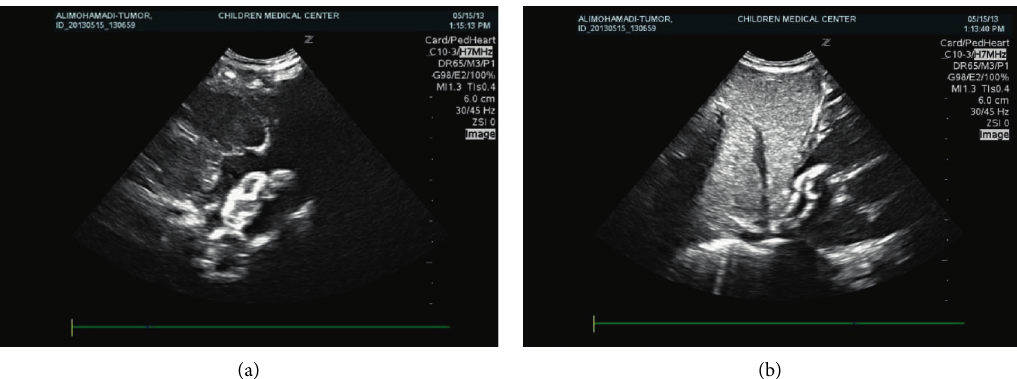
Figure 1: 2D transthoracic, subcostal view demonstrating the echogenic mass (arrow head) attached to the interatrium septum (a) and extension to the IVC